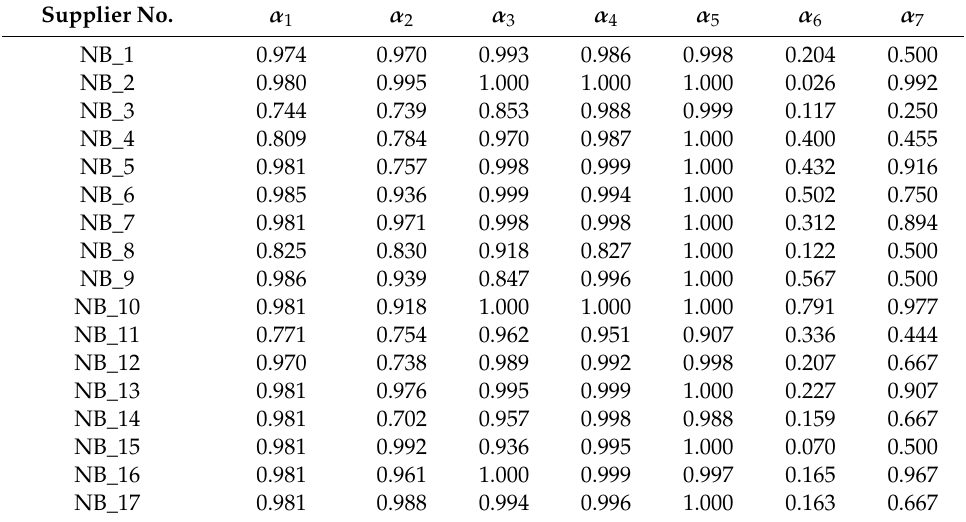
Table 3. Entries of the normalized decision making matrix for operation quality assessment of smart